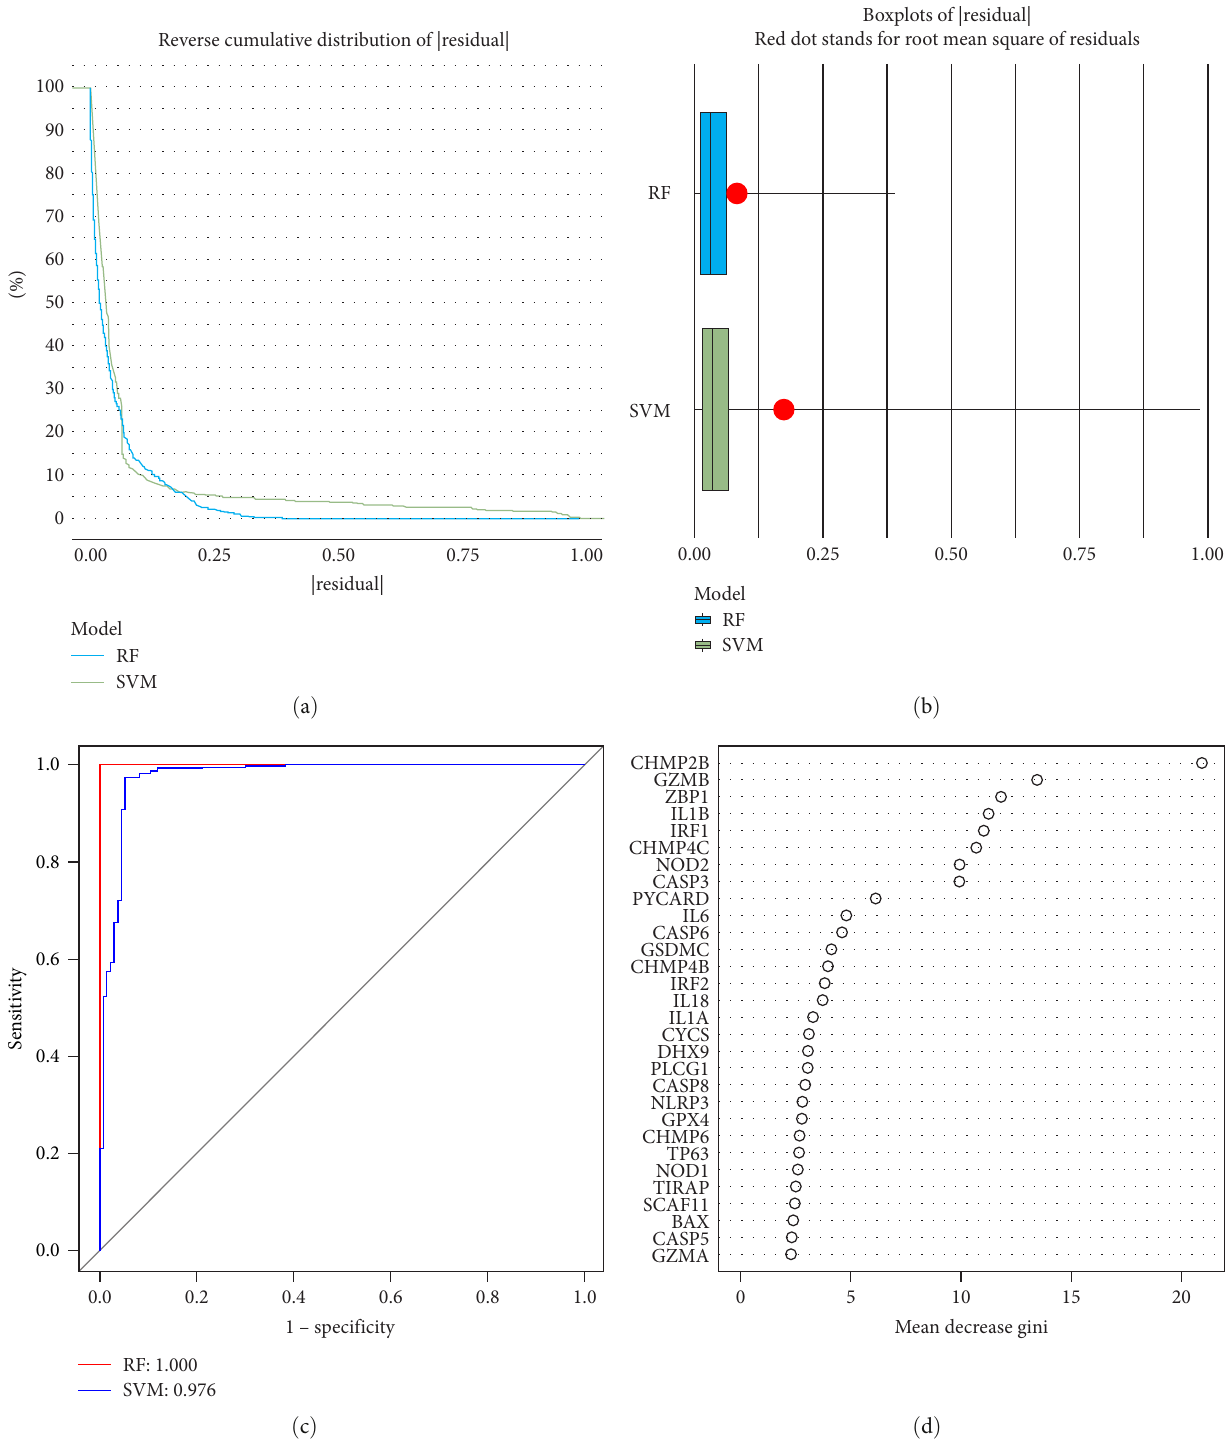
F IGURE 4: Construction of the RF model. (a, b) The residual distribution of the RF and SVM models. (c) The accuracy of the RF and SVM models was evaluated by the area under the ROC curves. (d) The top 30 PRGs was selected according to the importance ranking. RF, random forest; SVM, support vector machines; ROC, receiver operating